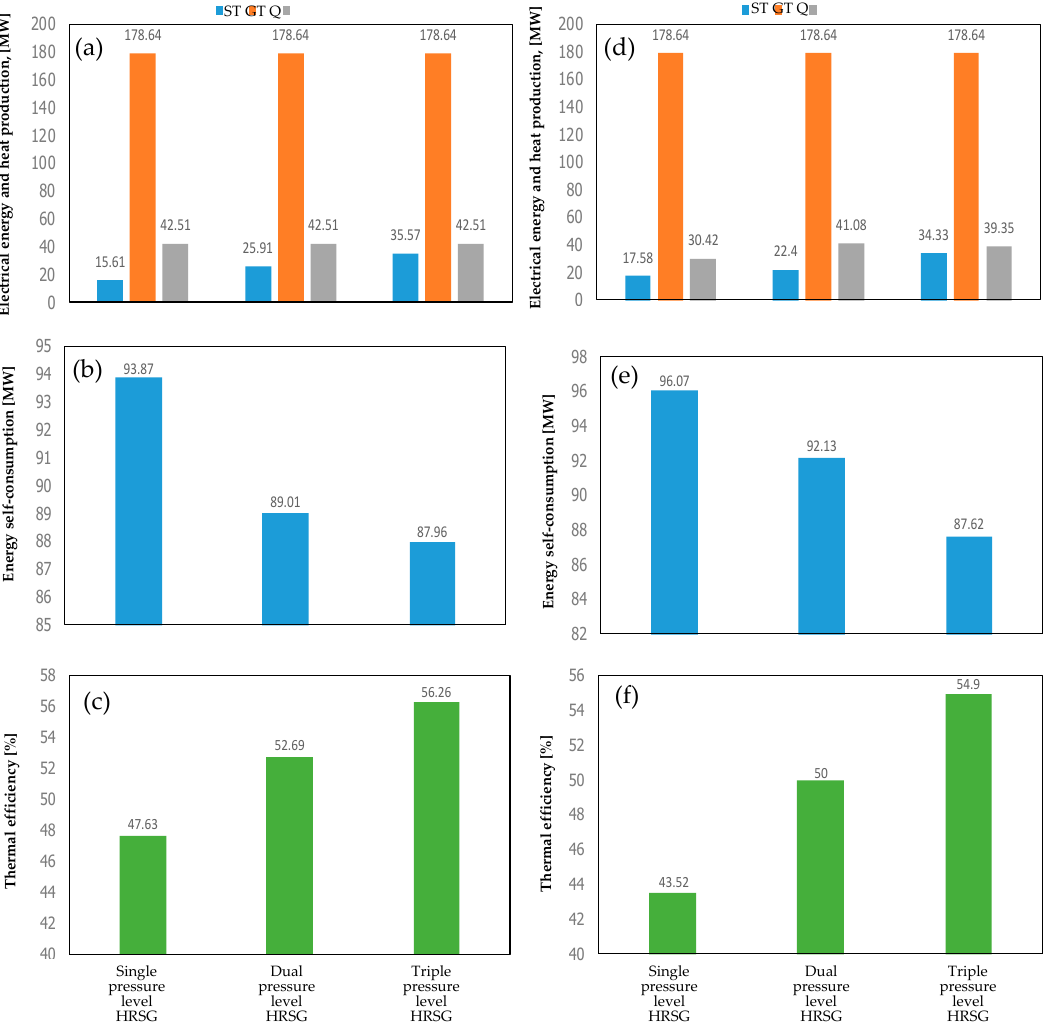
Figure 4. Electrical energy generation from GT, ST and heat production Q ( a , d ), energy self-consumption, ( b , e ) and the overall system thermal efficiency ( c , d ) for the system with 1P, 2P, and 3P HRSG with a steam regeneration system ( a – c ) and with inter-stage superheating and regeneration of steam ( d – f ). Table 6. Working parameters and assumptions for thermodynamic analysis.